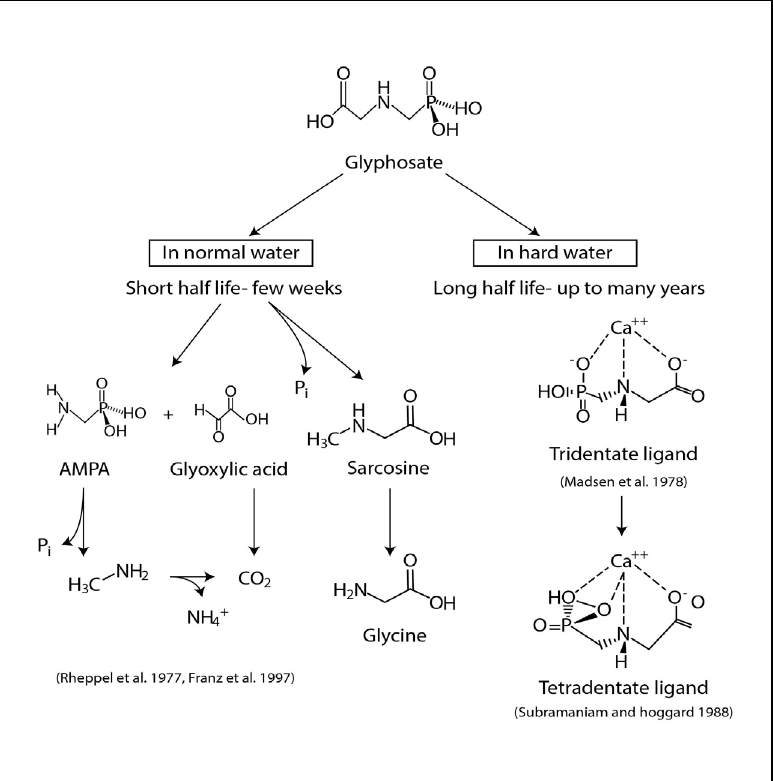
Figure 3. Degradation pathways of glyphosate in normal water and in hard